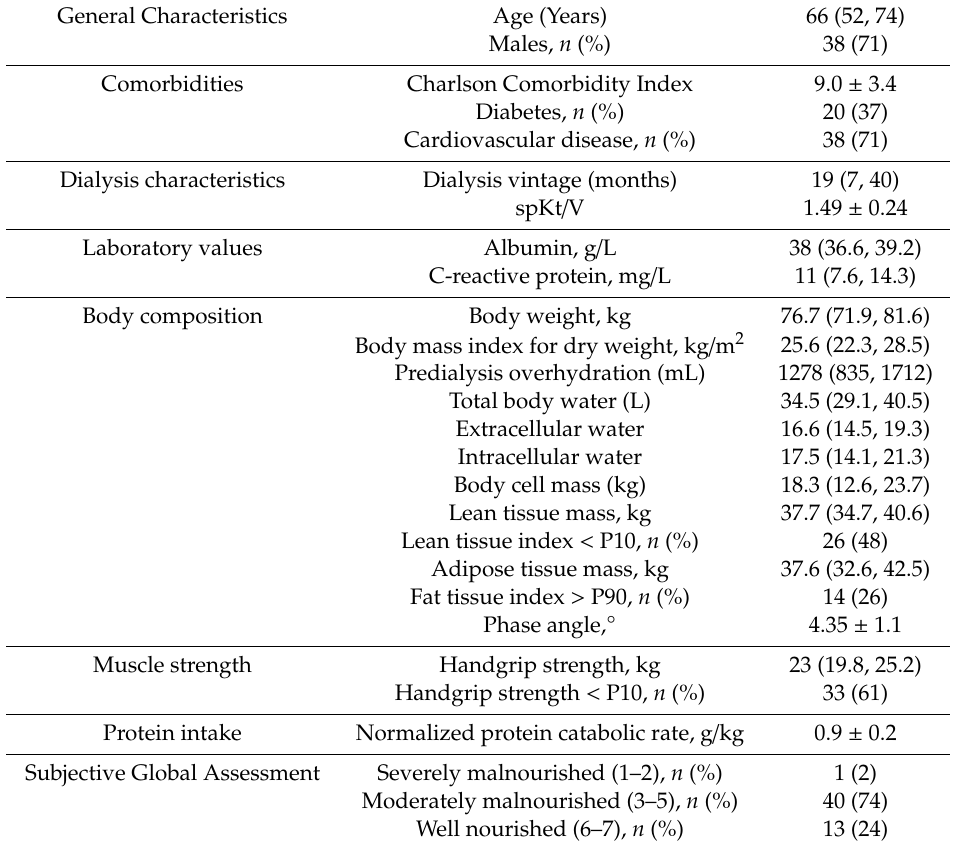
Table 1. Baseline characteristics of study cohort ( n =